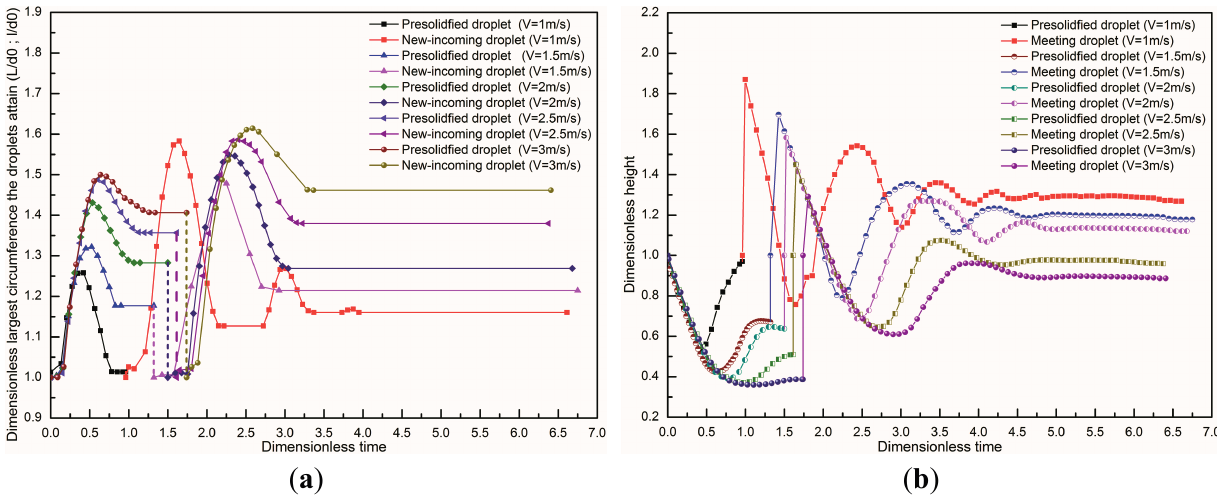
Figure 8. Temporal evolution of ( a ) dimensionless largest circumference and ( b ) dimensionless height during impacting of a molten aluminum alloy droplet on a stainless steel surface at temperature 350 K with velocity 1–3 m/s; the distance between the two successive droplets is 220 μ